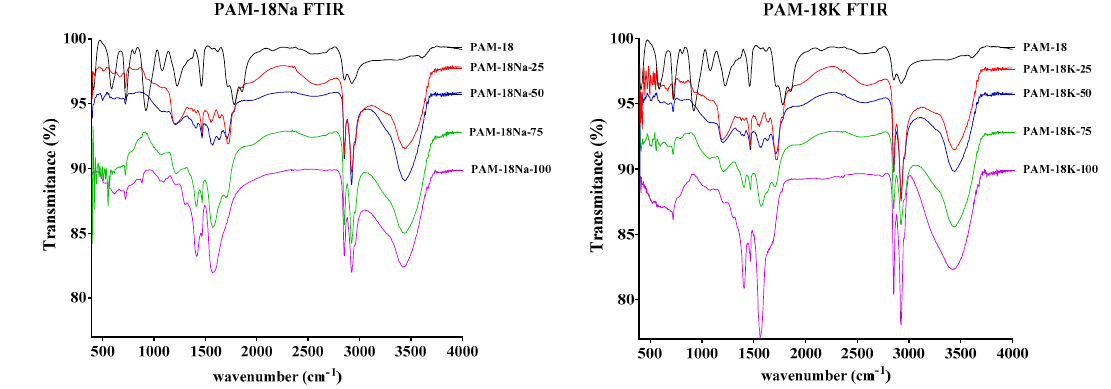
Figure 2. Fourier transform infrared (FT-IR) spectra of polymers derived from PAM-18.